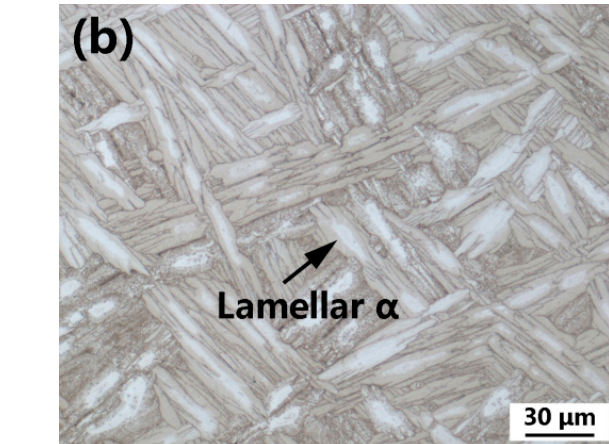
Figure 9. STEM images of the post-deposition STA Ti60 alloy: lamellar α ( a ) and silicides ( b ). 3.3. Mechanical Properties 3.3.1. Tensile Properties at Room Temperature and 600 °C Tensile properties for the EB-DED and wrought Ti60 alloys at room temperature and 600 °C are presented in Tables 3 and 4, respectively. The representative tensile engineering stress-strain curves are presented in Figure 10.